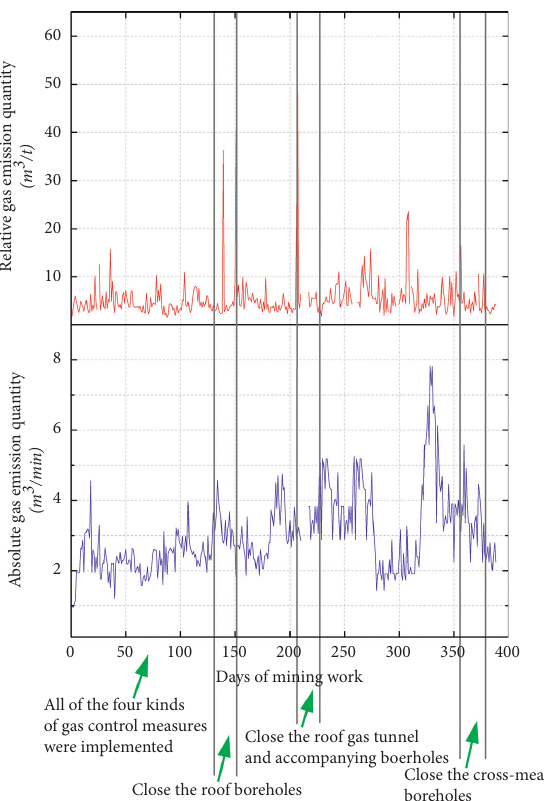
Figure 12: Variations of absolute and relative gas emission quantity during mining work when using different gas drainage measures in No. 2 1024 panel.